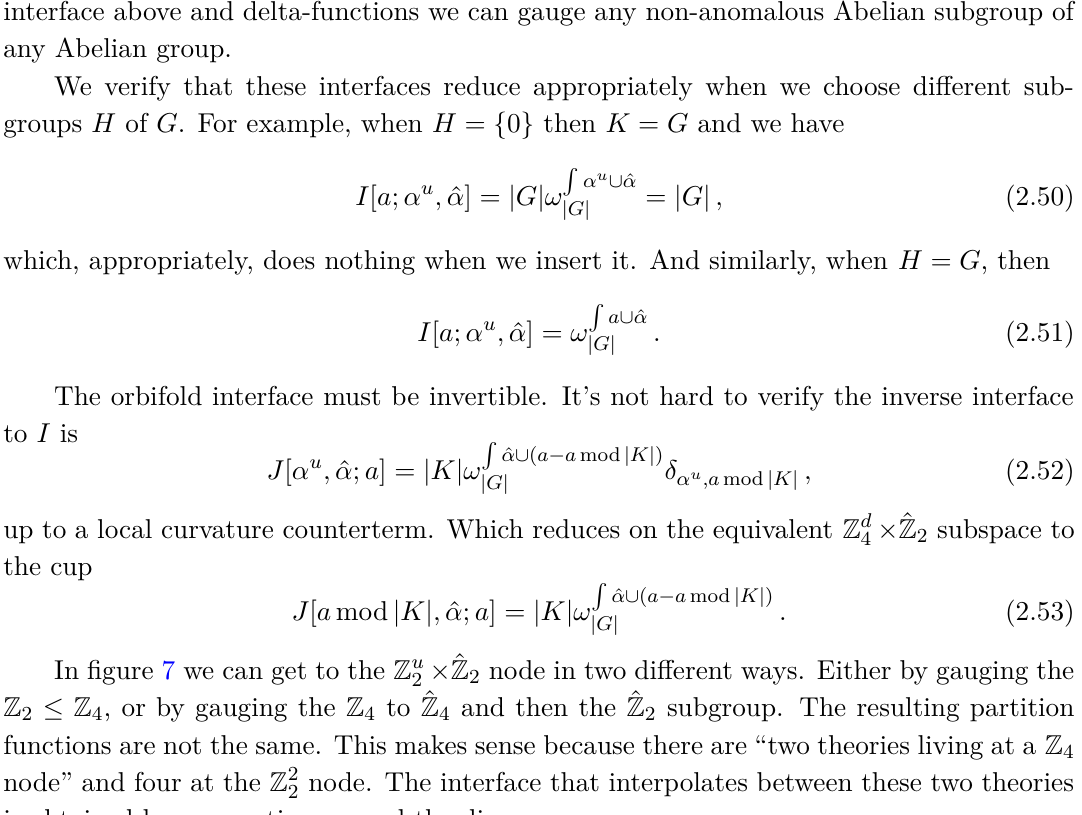
Figure 7 . Gauging the Z 4 symmetry of a Z 4 theory produces a theory with a Gauging the Z subgroup of either produces an anomalous 2